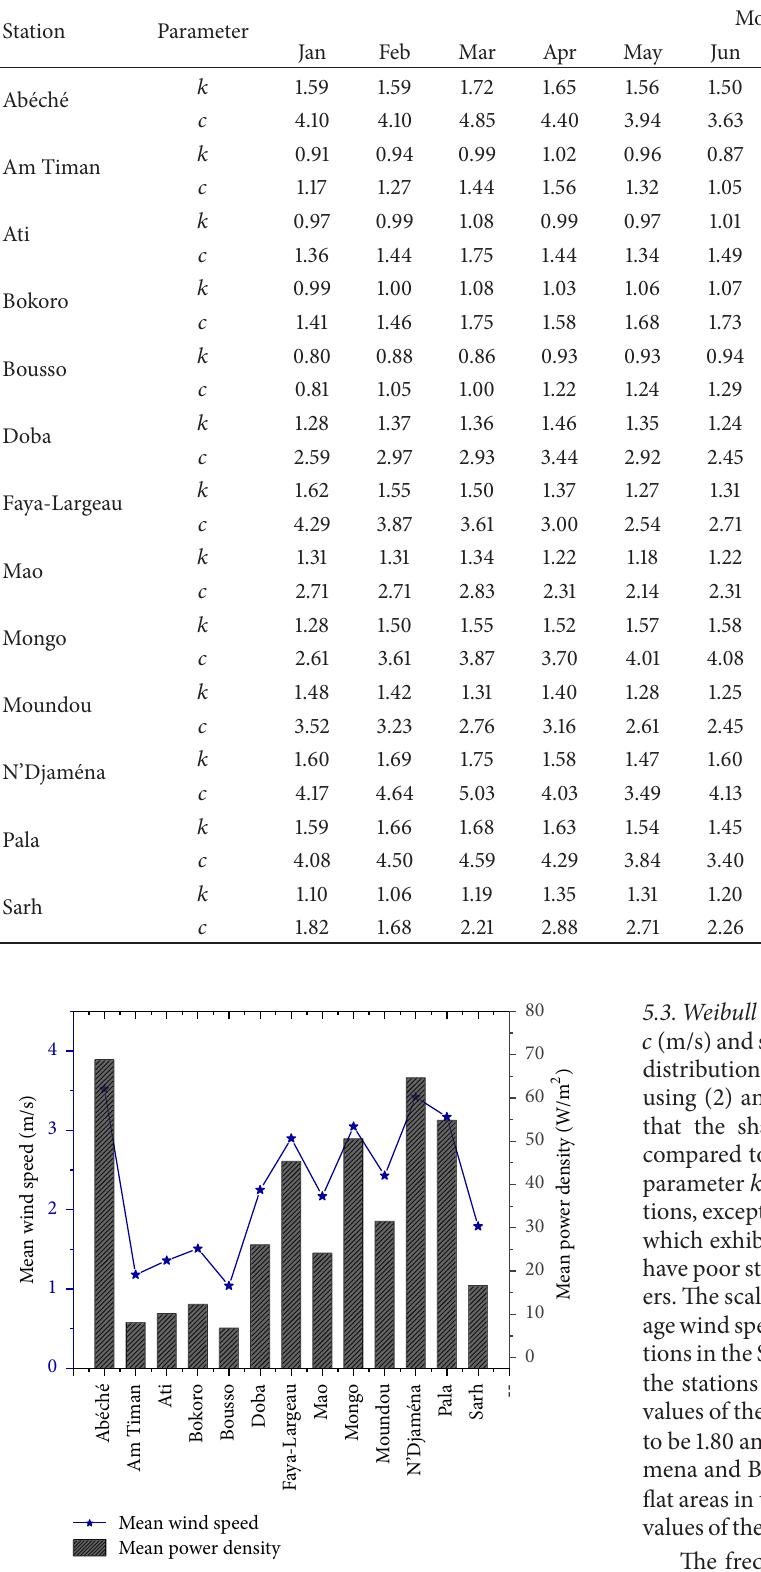
Figure 4: Comparison of yearly mean wind speeds and mean wind power